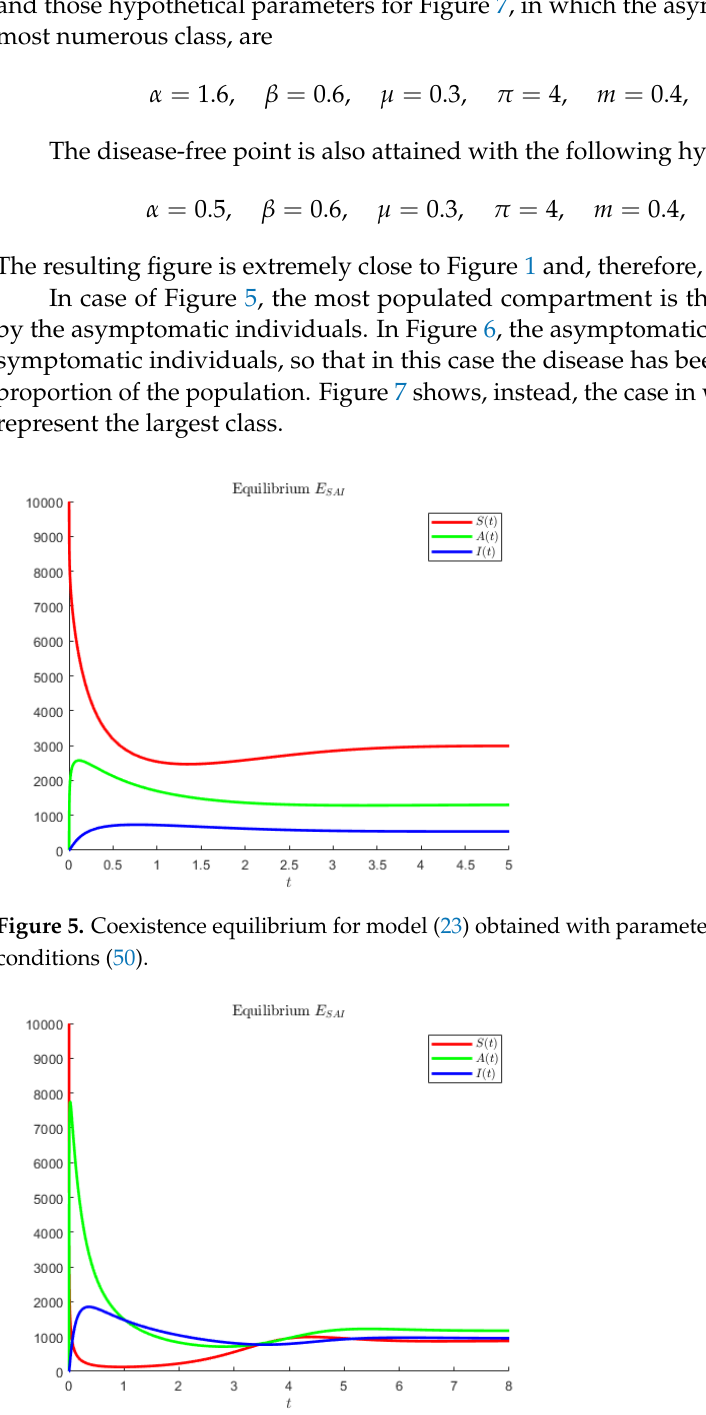
Figure 6. Coexistence equilibrium for model (23) obtained with parameter values (57), (51) and initial conditions